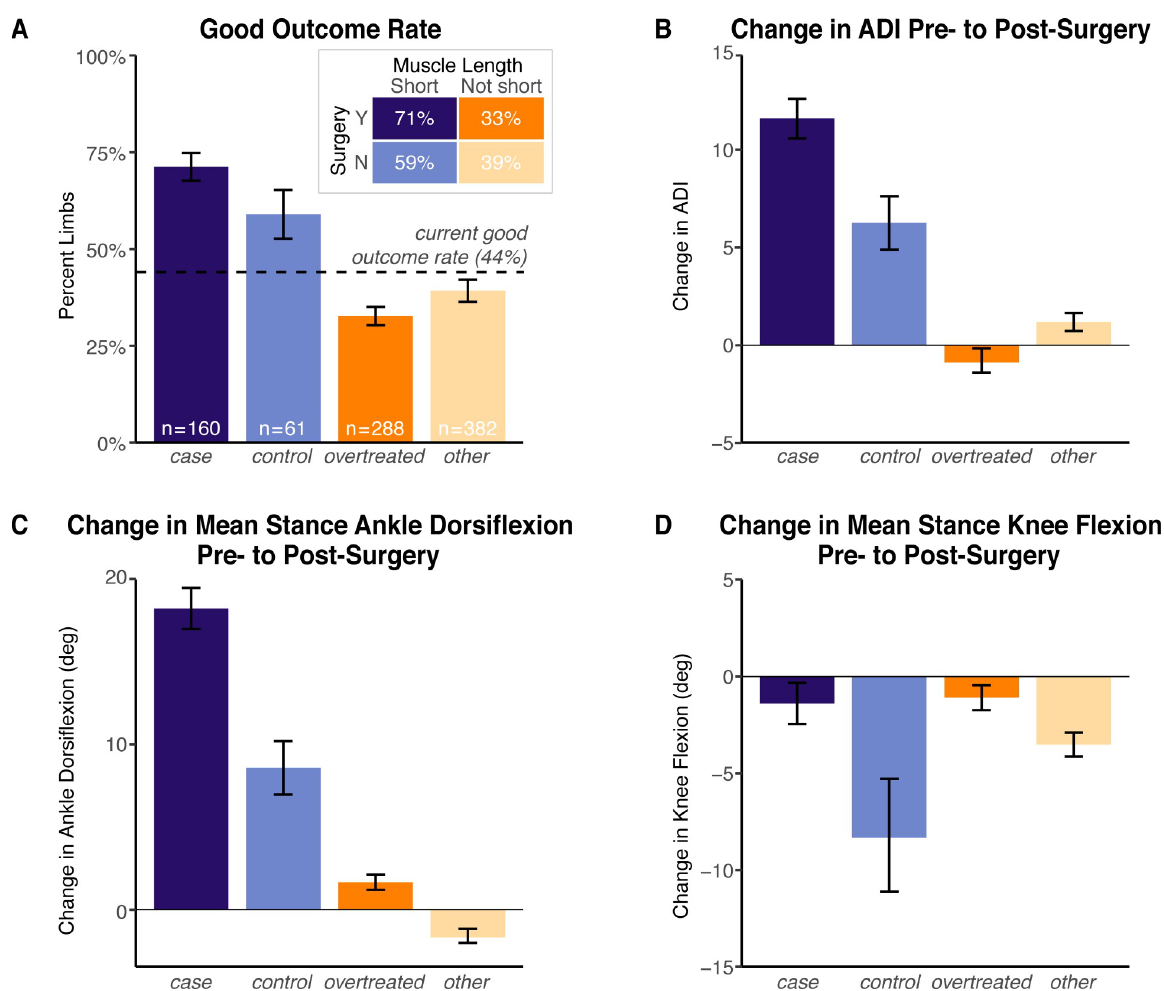
Fig 5. Cross-classified short-term improvements following gastrocnemius lengthening surgery. Limbs were cross-classified based on those that underwent a gastrocnemius lengthening surgery ( case and overtreated ) and those labeled as having a short pre-surgery gastrocnemius ( case and control ). (A) Good outcome rates, defined as the fraction of limbs that had at least a 5-point improvement in ADI, or an improvement in ADI with post-surgery ADI > 90, were computed per group. The current good outcome rate was computed from retrospective data from all limbs that underwent gastrocnemius lengthening surgery. Changes in the (B) ADI, (C) mean stance ankle dorsiflexion angle, and (D) mean stance knee flexion angle were computed from the pre-surgery to post-surgery clinical gait visit. Kinematic improvements in the case limbs exceeded those of the overtreated and control limbs. Limbs, on average, did not tend to devolve into a crouch gait, even within the overtreated limbs. In all panels, error bars represent ± 1 standard error of the